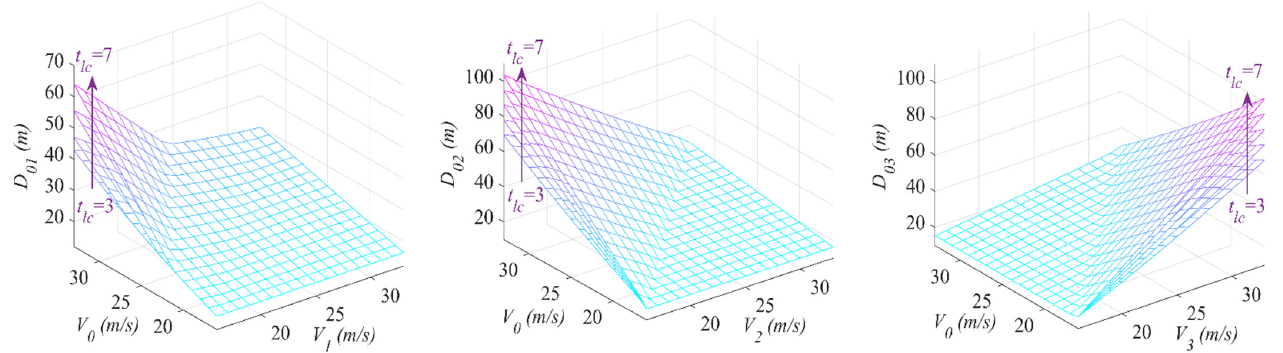
Figure 2. Variation of lane-changing safety distance with t lc .